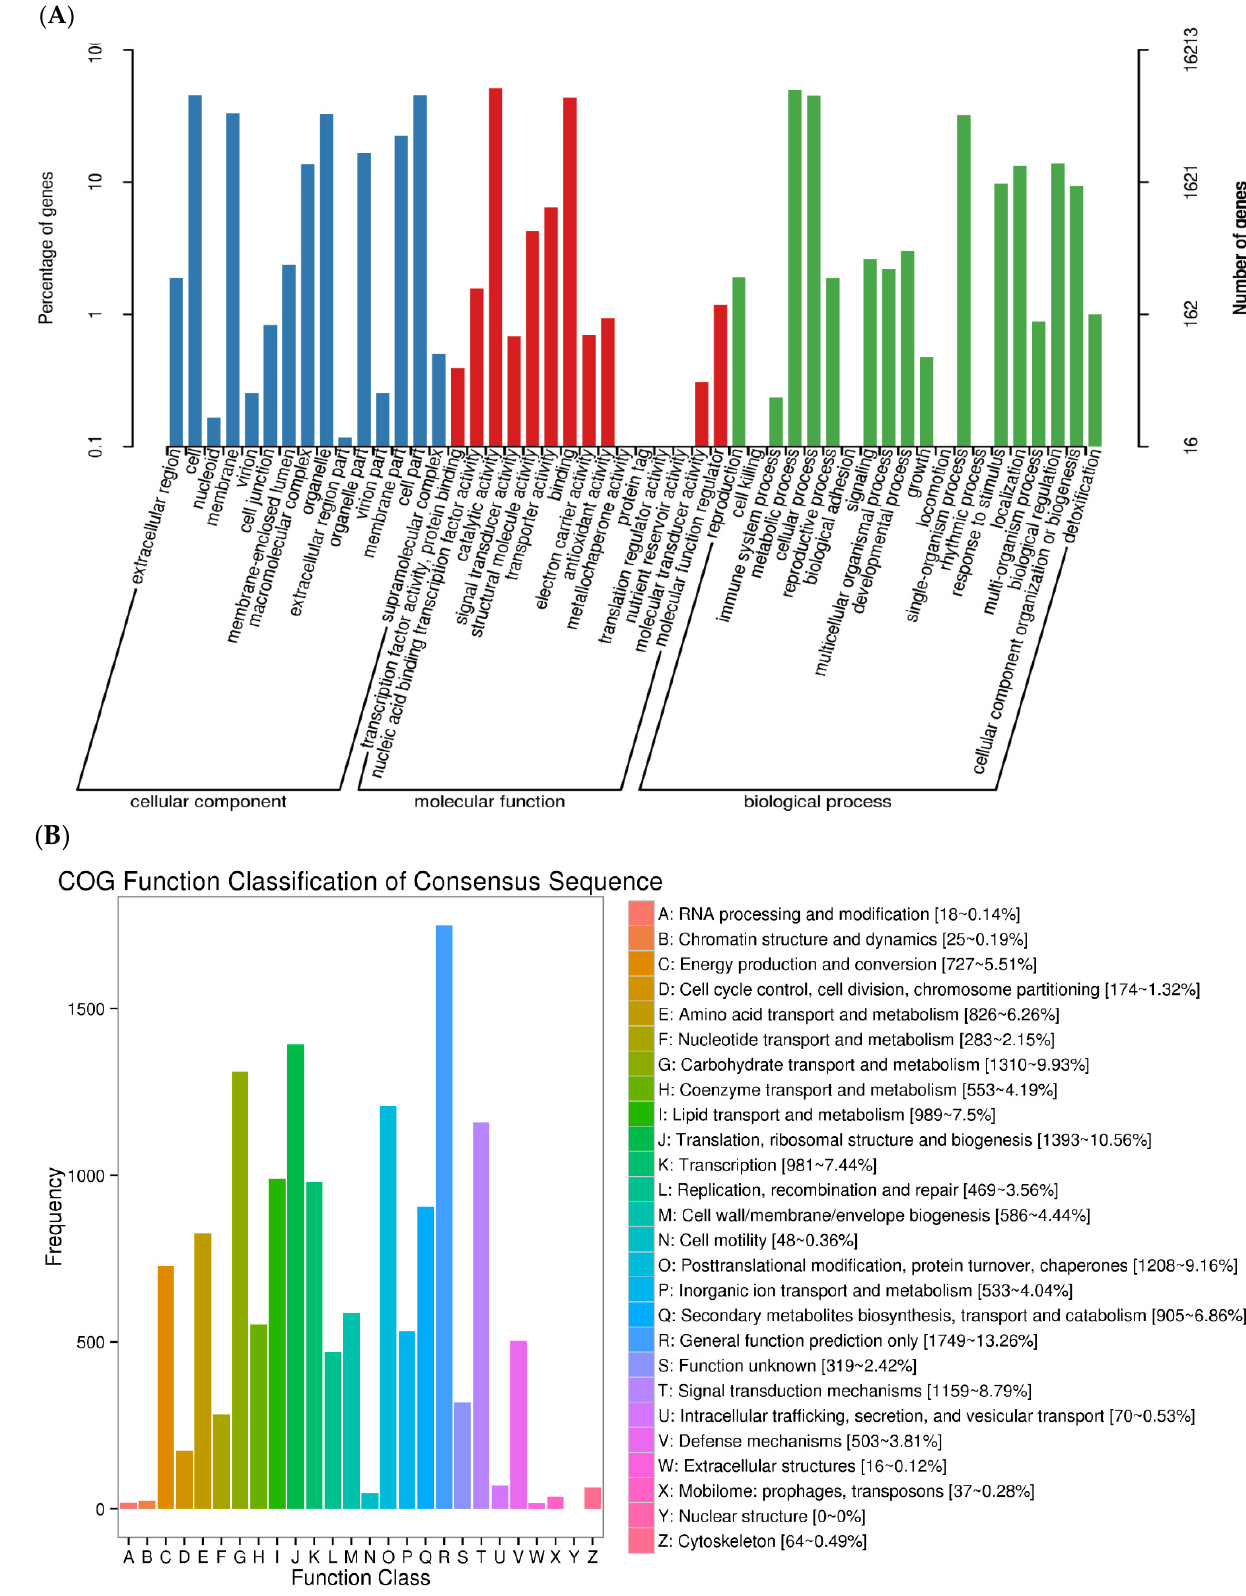
Figure 2. Classification of enriched GO and COG terms. ( A ) GO classifications of annotation unigenes. ( B ) All unigenes were assigned to different COG terms.